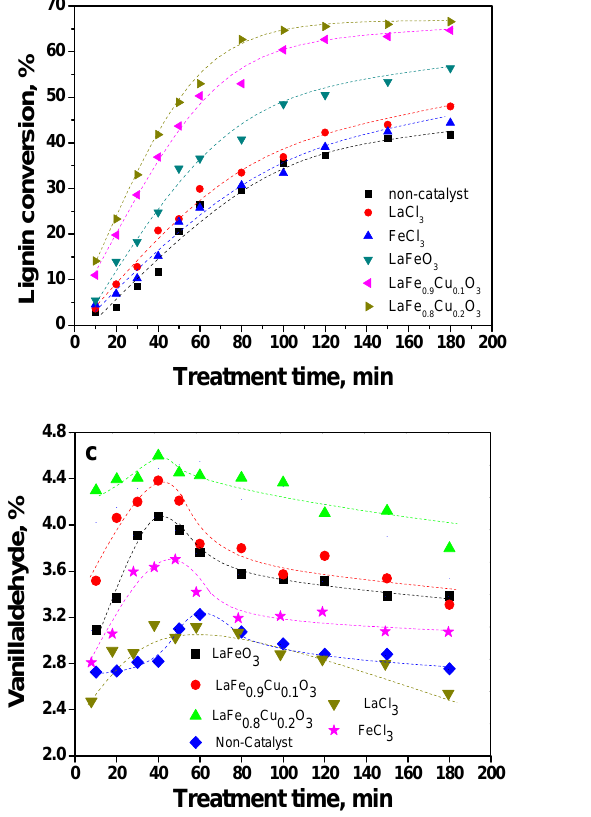
-C )/C , where C is the 0 t 0 0